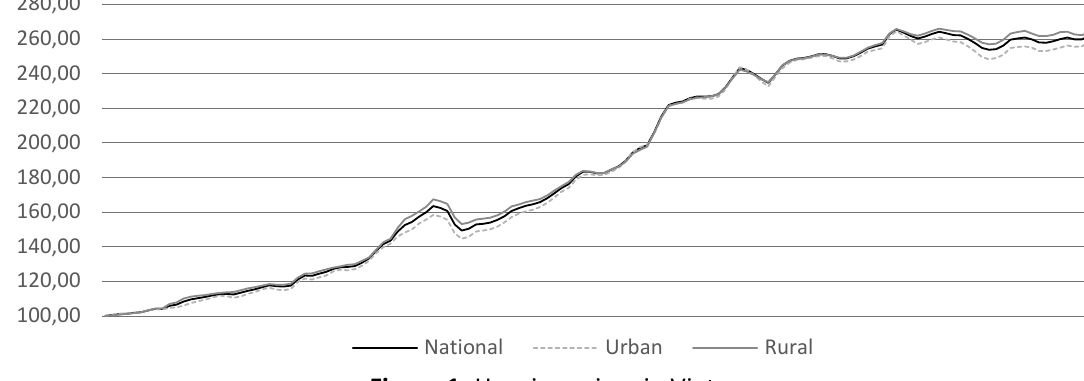
Figure 1. Housing prices in Vietnam